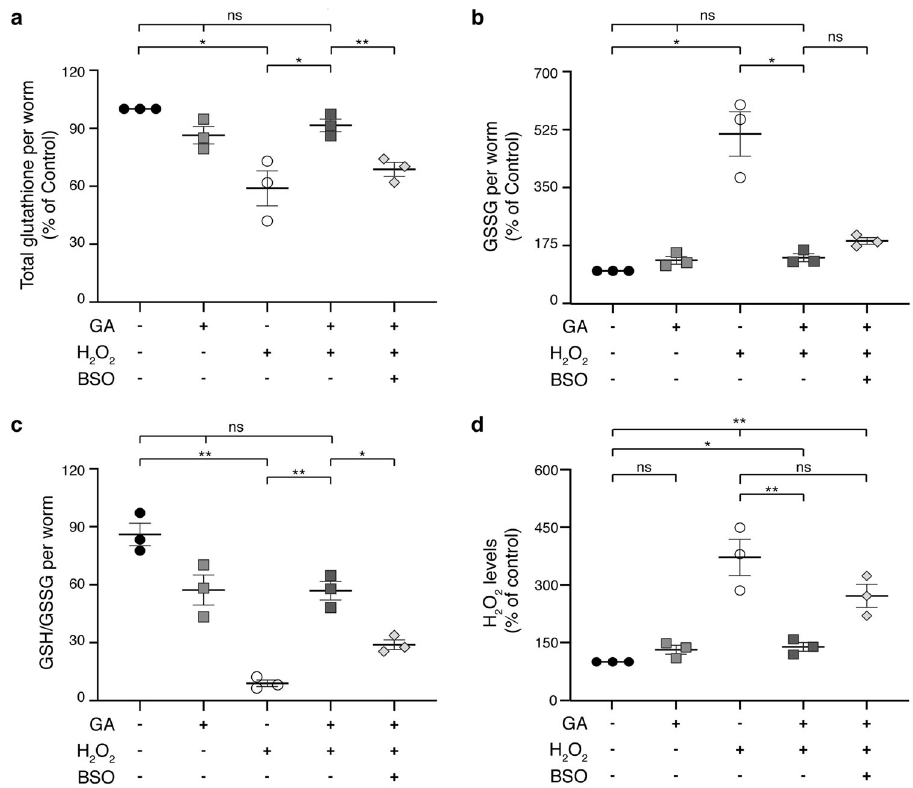
Fig. 3 Glycolate addition prevents the drop in the antioxidant capacity of glutathione caused by peroxide. a Total glutathione (GSH + GSSG), b GSSG, c ratio of GSH to GSSG levels, and d H 2 O 2 levels in animals exposed to 100 mM H 2 O 2 and supplemented or not with glycolate and BSO. Values were determined after 3 days of treatment and normalized to number of worms. In d H 2 O 2 accumulation was measured with AmplexRed and fl uorescence intensity was normalized to protein levels. 100 mM H 2 O 2 , 10 mM glycolate (GA) and 0.5 mM BSO were used as indicated. Error bars represent standard error of the mean ( n =